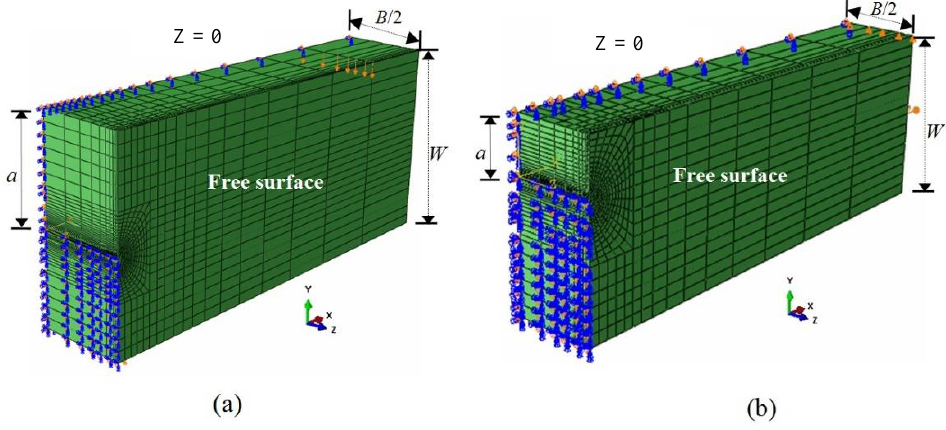
/ 4 model). ( a ) SENB with a / W = 0.5; ( b ) SENT with a / W = Figure 4. 3D FE models (1/4 model). ( a ) SENB with a/W = 0.5; ( b ) SENT with a/W = 0.3. Figure 4. 3D FE models (1